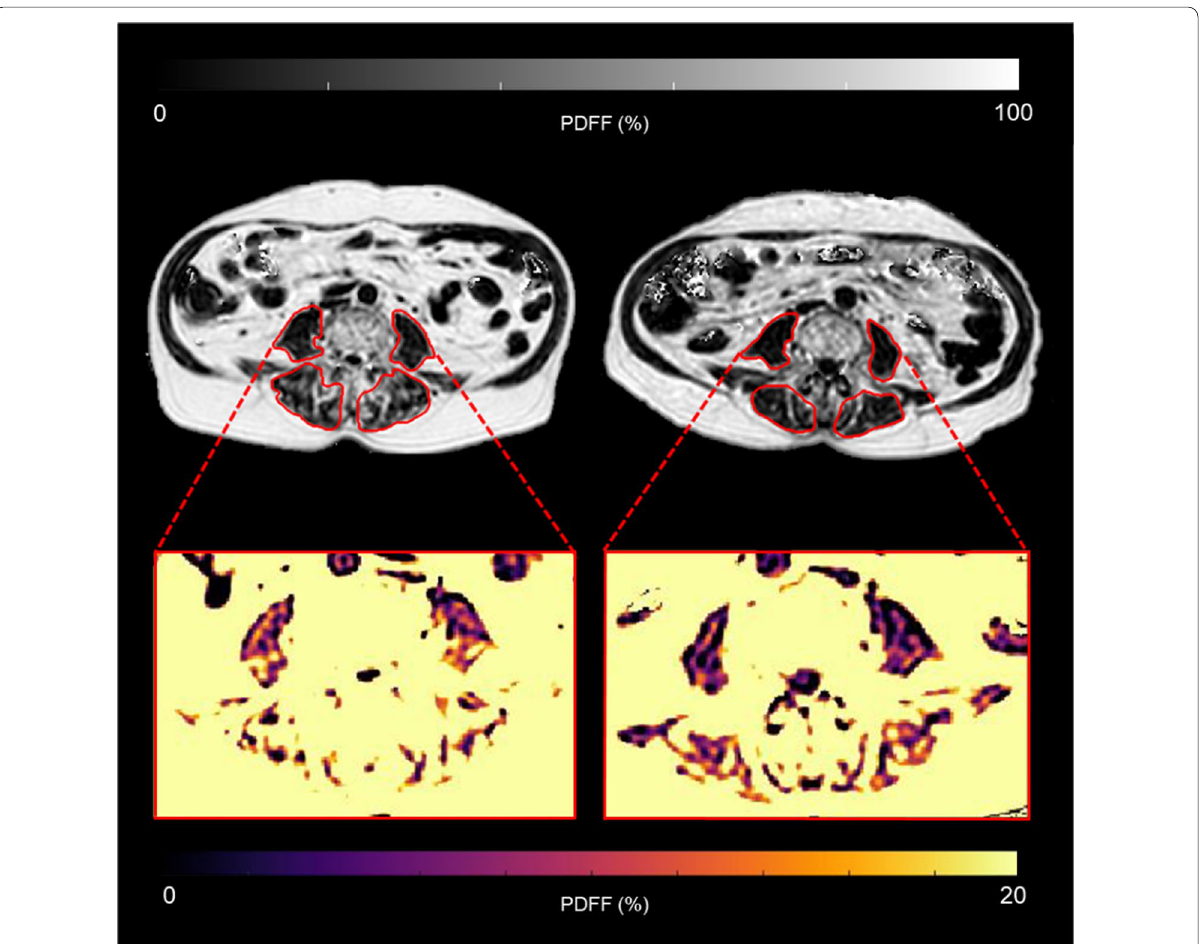
Fig. 3 Skeletal paraspinal muscle changes in a patient with cancer cachexia: axial abdominal MRI scan of a 74 year-old patient with squamous cell carcinoma of the esophagus at baseline (left image) and follow-up after 335 days (right image). Relative muscle volume change was the erector spinae and 26.3% for the psoas muscle. Relative change of contractile tissue volume was − in psoas muscle. Relative change in fat volume